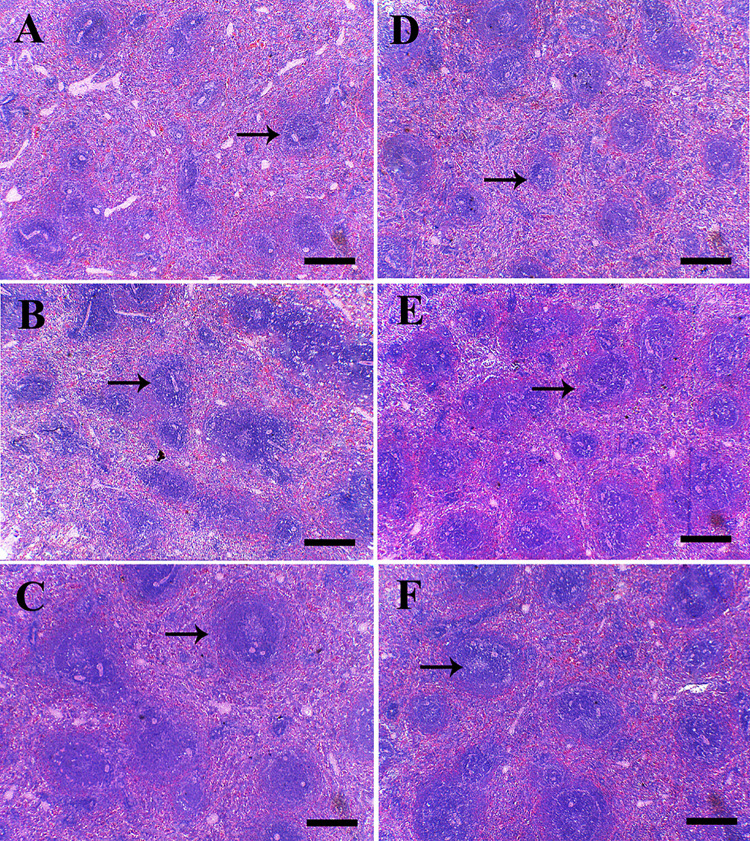
Light micrographs of spleen showing the effect of different doses of β glucan; control, 0.25 g β glucan (βG0.25), 0.5 g β glucan (βG0.5) on the two rabbit species; New Zealand White (NZW) and APRI rabbits were represented in (A to C) and from (D to F), respectively. The micrographs revealing the increasing in the whole white pulp areas and the lymphoid nodules (arrows) diameter from (A to C) and from (D to F). H and E stain. Scale bar is 400 μm.